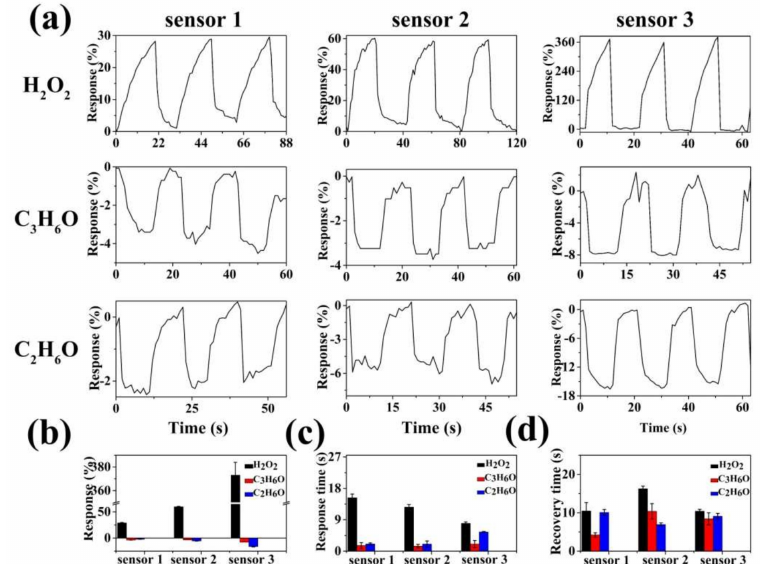
Figure 5. ( a ) Dynamic sensing curves of the devices based on sensor 1, 2, and 3 to 50 ppm of H 2 O 2 , C 3 H 6 O, C 2 H 6 O vapors at room temperature; statistical graph of ( b ) average response, ( c ) response time and ( d ) recovery time corresponding to the sensing